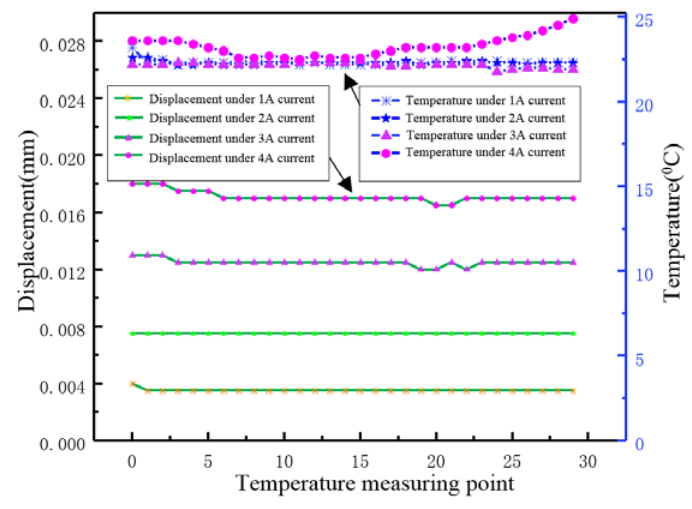
Figure 16. Static thermal expansion test of 1A to 4A DC.